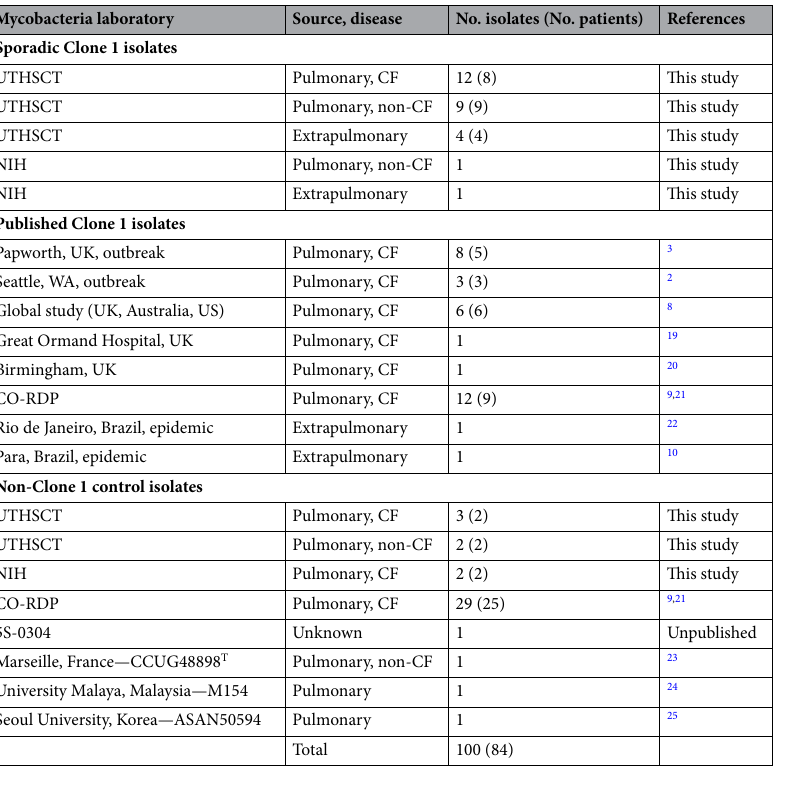
Table 1. M. massiliense isolate cohort for genomic